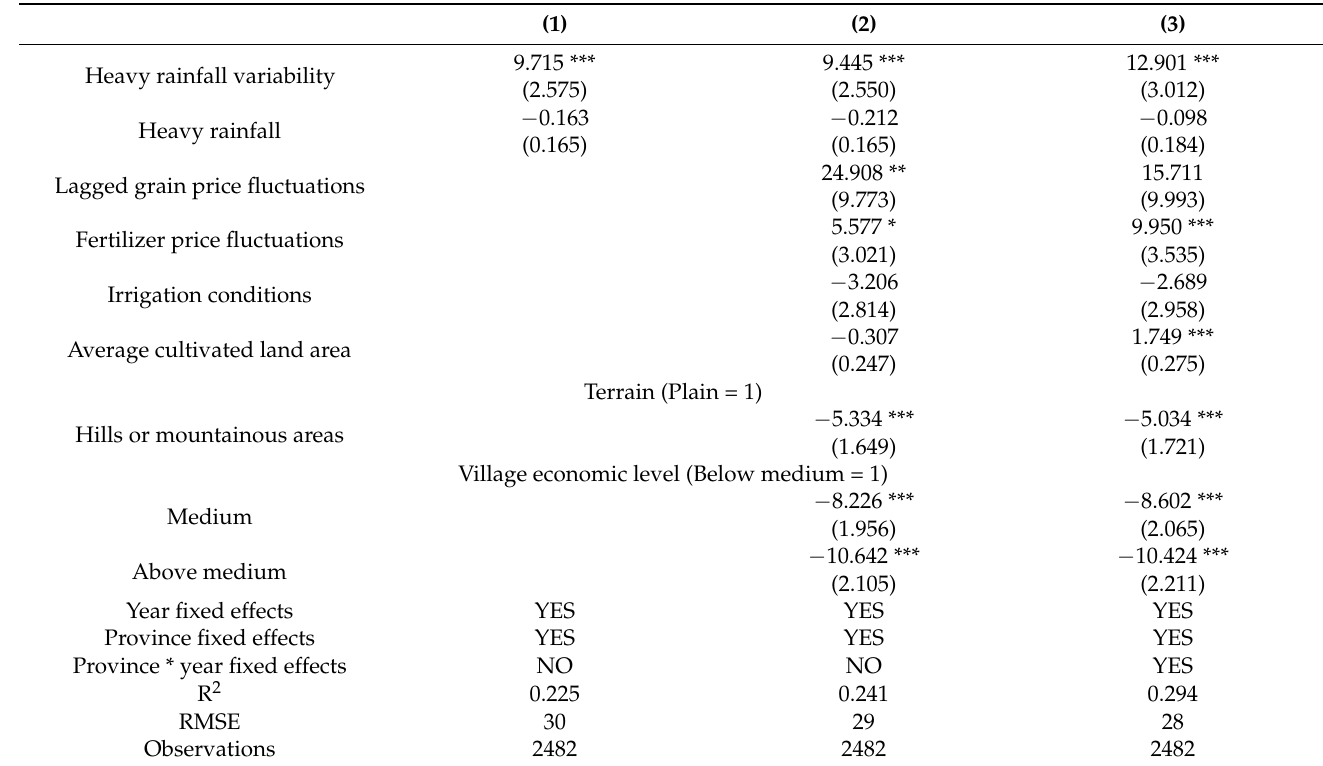
Table 6. Effects of heavy rainfall variability on yield